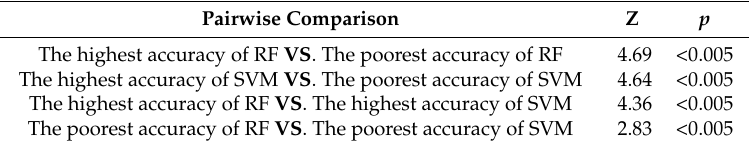
Table 6. Z-test values for the pairwise comparison of the error matrices of single temporal mapping. Pairwise